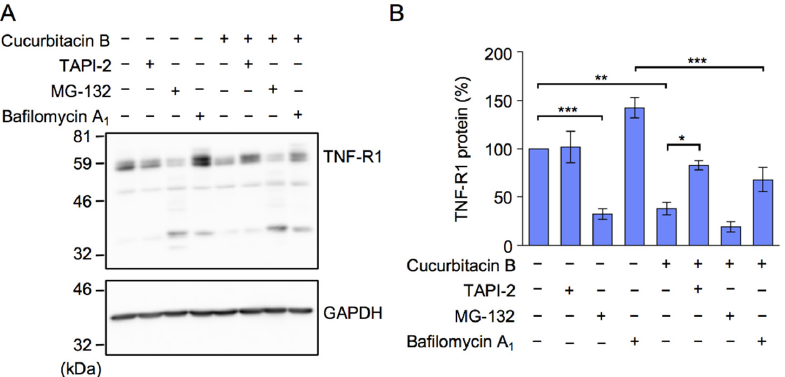
Figure 7. The TACE inhibitor TAPI-2 suppressed reductions in TNF-R1 protein levels by